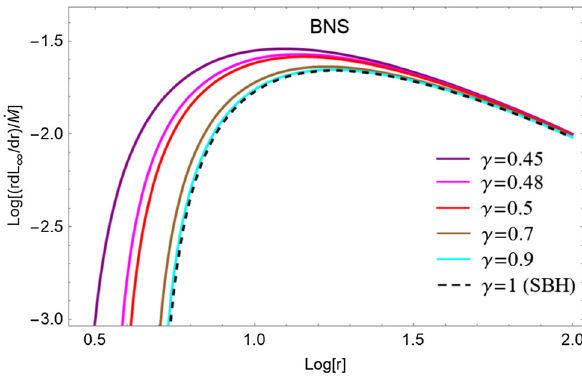
Fig. 8 Profile of the BNS differential luminosity, ( rd L ∞ / dr )/ ˙ M 0 , for different